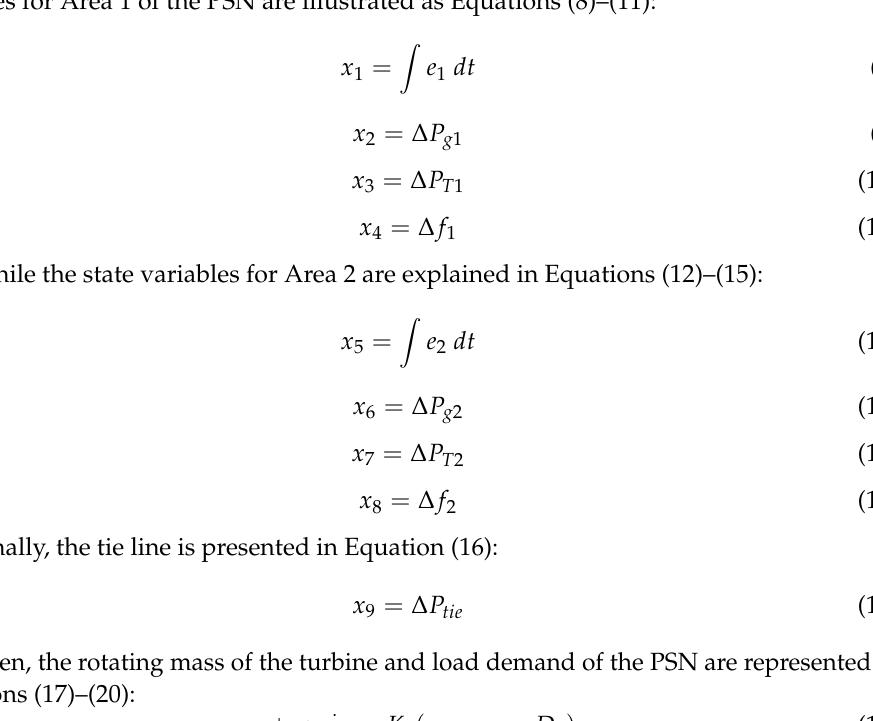
Figure 7. The block diagram of a two-area PSN based on a state space model.